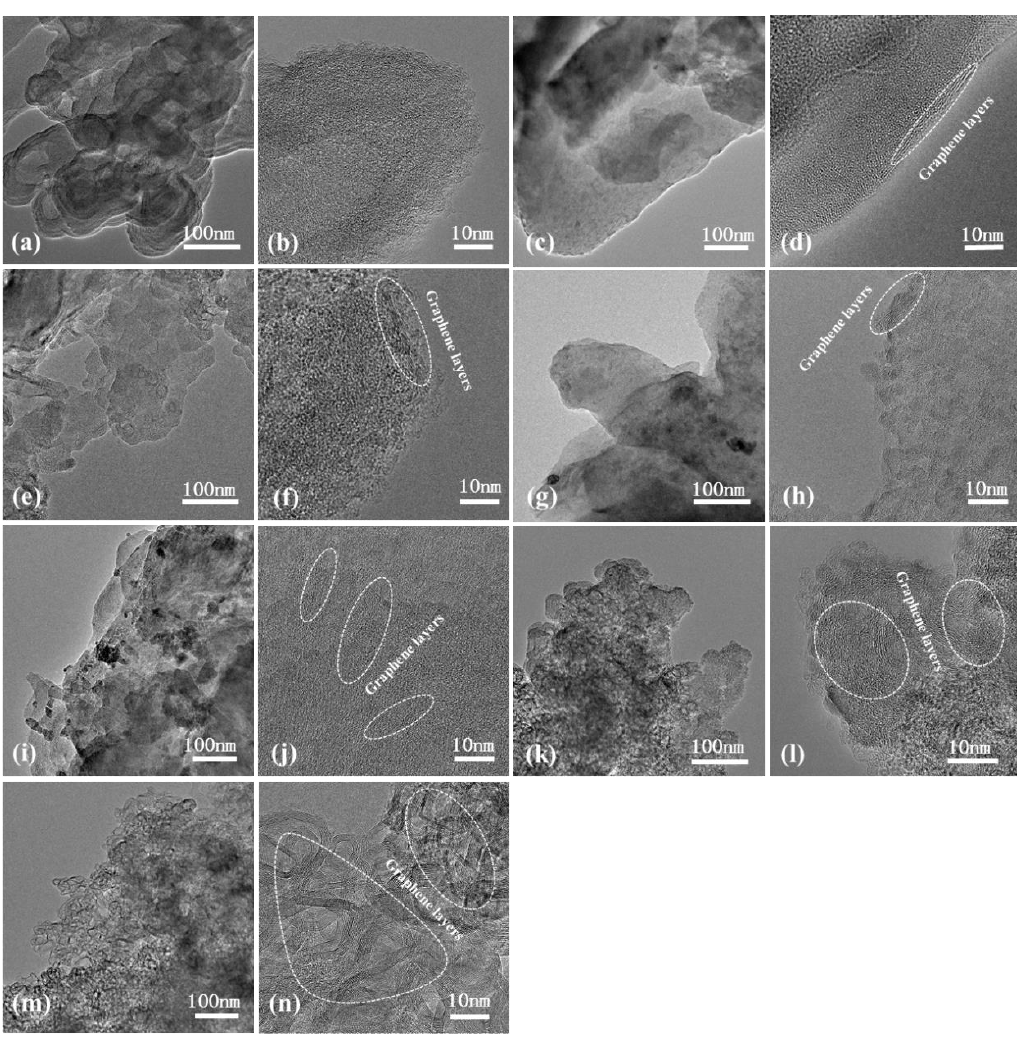
Figure 3. TEM images of NGS/WPU composites with different content of NGS: ( a , b ) 0 wt%, ( c , d ) 0.001 wt%, ( e , f ) 0.003 wt%, ( g , h ) 0.005 wt%, ( i , j ) 0.007 wt%, ( k , l ) 0.01 wt%, ( m , n ) 0.03 wt%. High-